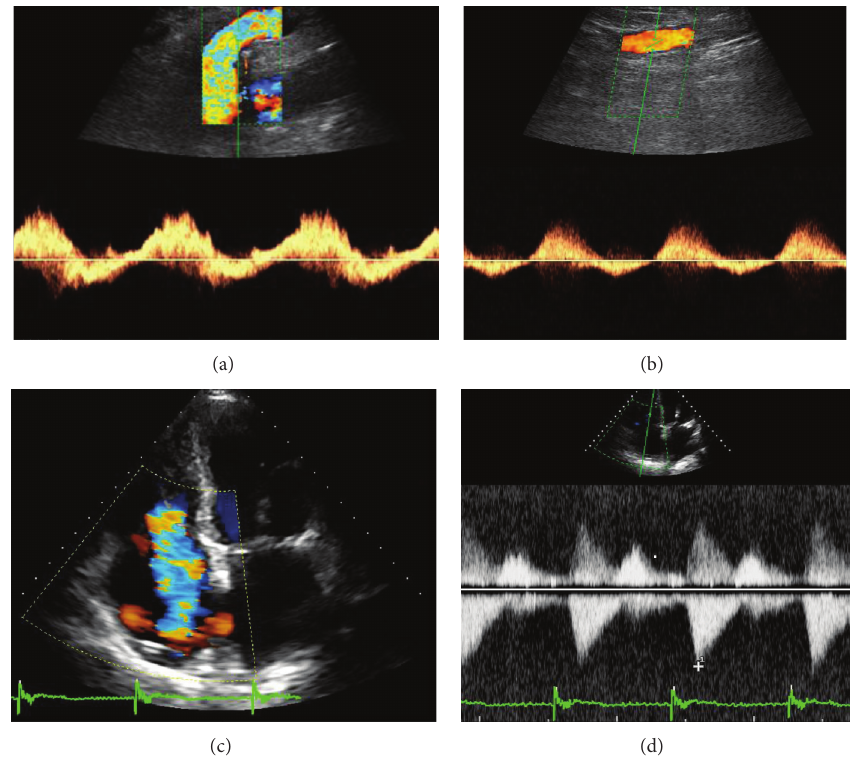
Figure 1: (a) Abnormal pulsatile flow with a retrograde component in saphenous femoral junction. (b) Abnormal pulsatile flow with a retrograde component along the great saphenous vein. (c) Transthoracic echocardiography: severe tricuspid regurgitation at the color Doppler. (d) Transthoracic echocardiography: continuous wave Doppler, showing early peaking and triangular shape of tricuspid regurgitation